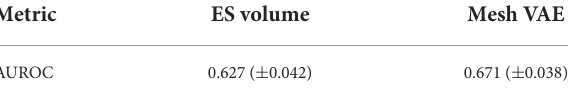
the obtained averaged meshes in Figure 7A for ED data and in Figure 7B for ES data.